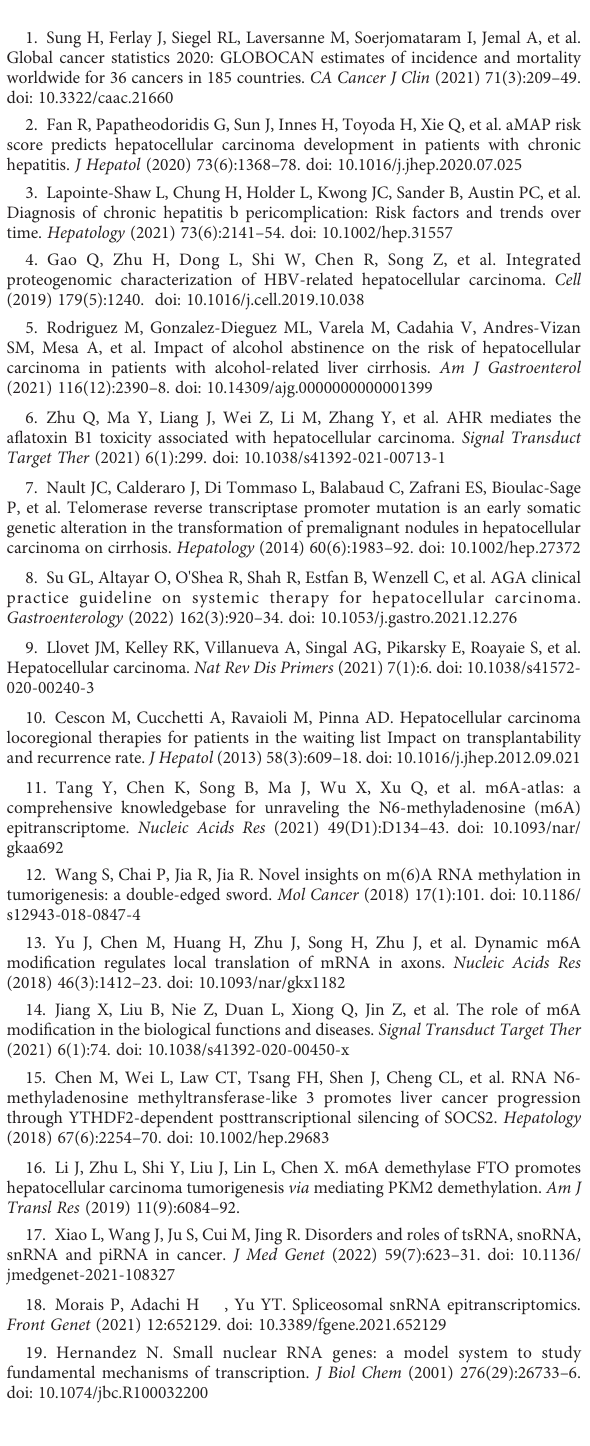
SUPPLEMENTARY FIGURE 1 Kaplan-Meier curve analysis of OS in female low- and high-risk HCC patients on clinicopathological characteristics (including age, grade, and TNM staging).